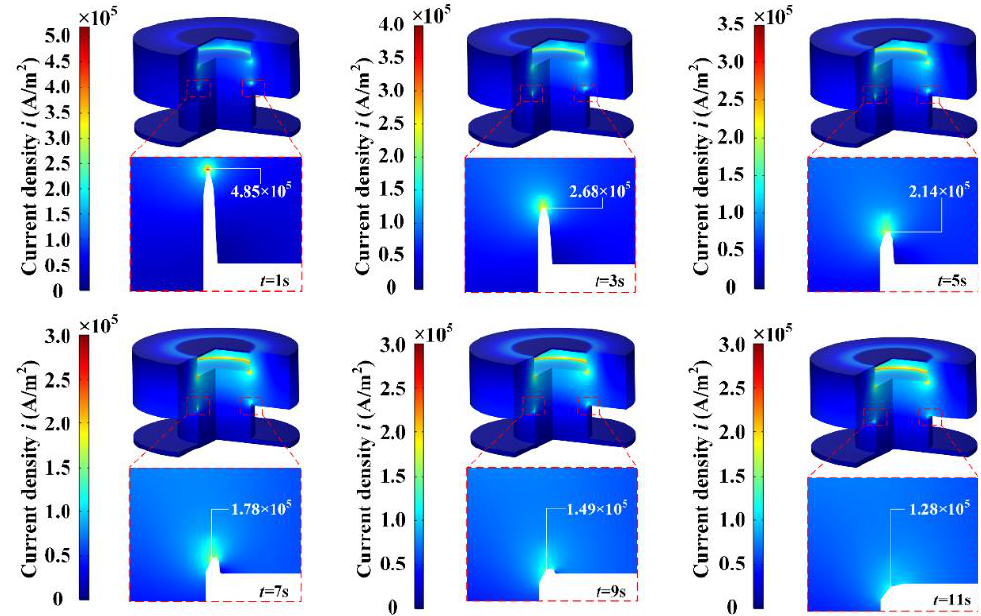
Figure 6. Electrolyte current density distribution.